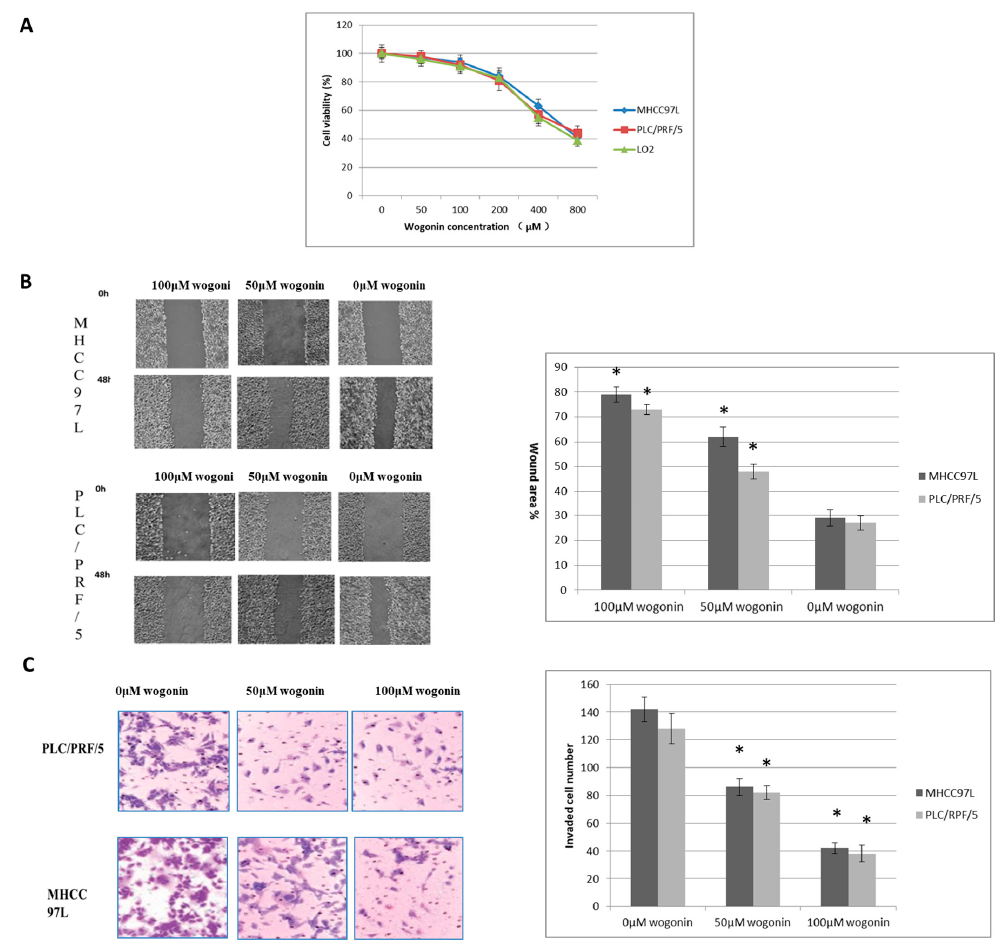
Figure 1. Wogonin inhibited invasion and migration in a dose-dependent manner in MHCC97L and PLC/PRF/5 cell lines. ( A ) Wogonin decreased the cell viability in a dose-dependent manner, and the IC50 against MHCC97L and LO2 cells at 48 h was 486 µ M and 424 µ M, respectively; ( B ) HCC cells were scratched and incubated with wogonin (0, 50, and 100 µ M). The scar closure area was detected by measuring the distance of the wound surface healing after treatment; ( C ) After treating with wogonin (0, 25, and 50 µ M) for 24 h, the cell invasion ability was significantly inhibited in a dose-dependent manner. (* p < 0.05 versus no wogonin treatment group).